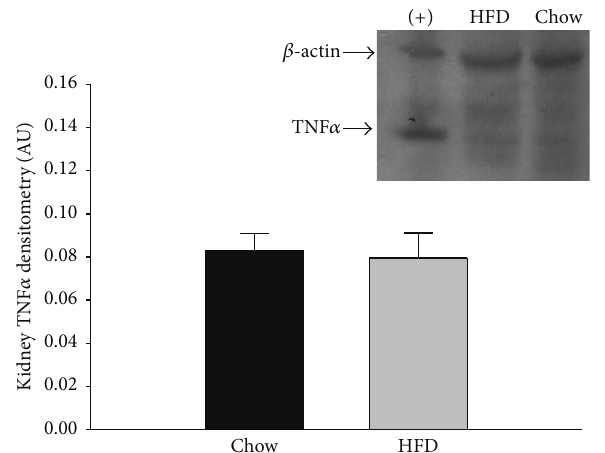
Figure 2: Renal tissue TNF 𝛼 protein expression in chow and HFD rats. There was no difference in the TNF 𝛼 expression of the two diet groups ( 𝑛 = 8 /group). Retroperitoneal adipose tissue from a HFD ratwasusedasapositivecontrol(+)andisshowninthefirstcolumn. Data were analyzed by Student’s 𝑡 -tests and are expressed as means ± SEM. 𝑝 = 0.803 .